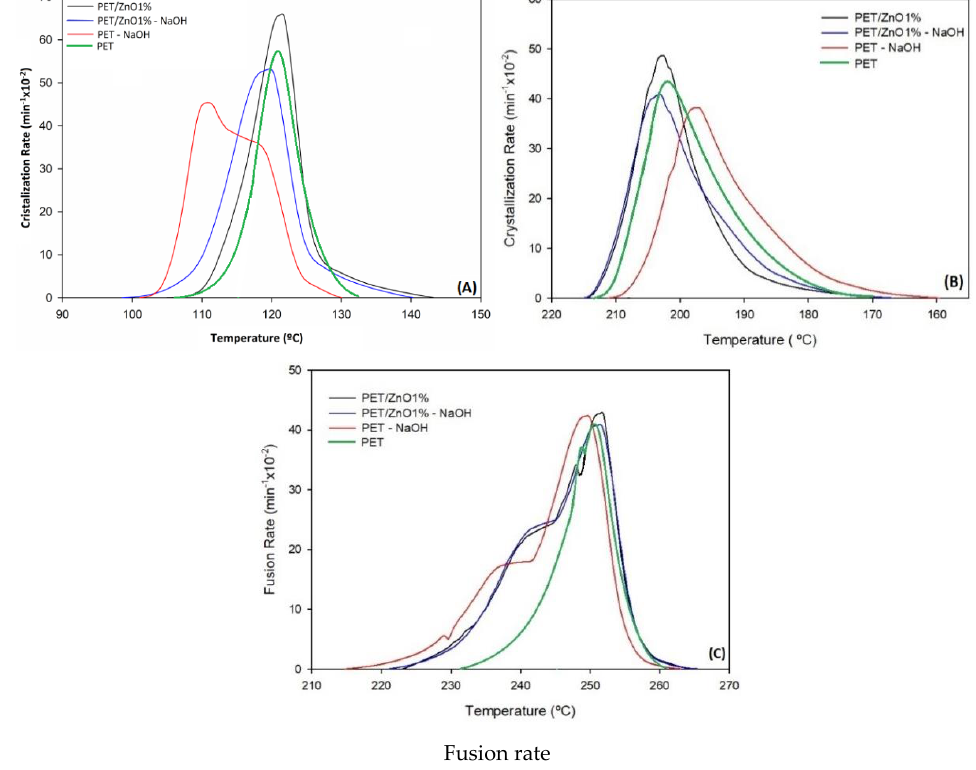
Figure 5. Crystallization and fusion rates according to temperature for various compounds. ( A ) Cold crystallization. ( B ) Melt crystallization. ( C ) Fusion. Table 2. Thermodynamic and kinetic parameters of crystallization and fusion obtained from DSC scans.